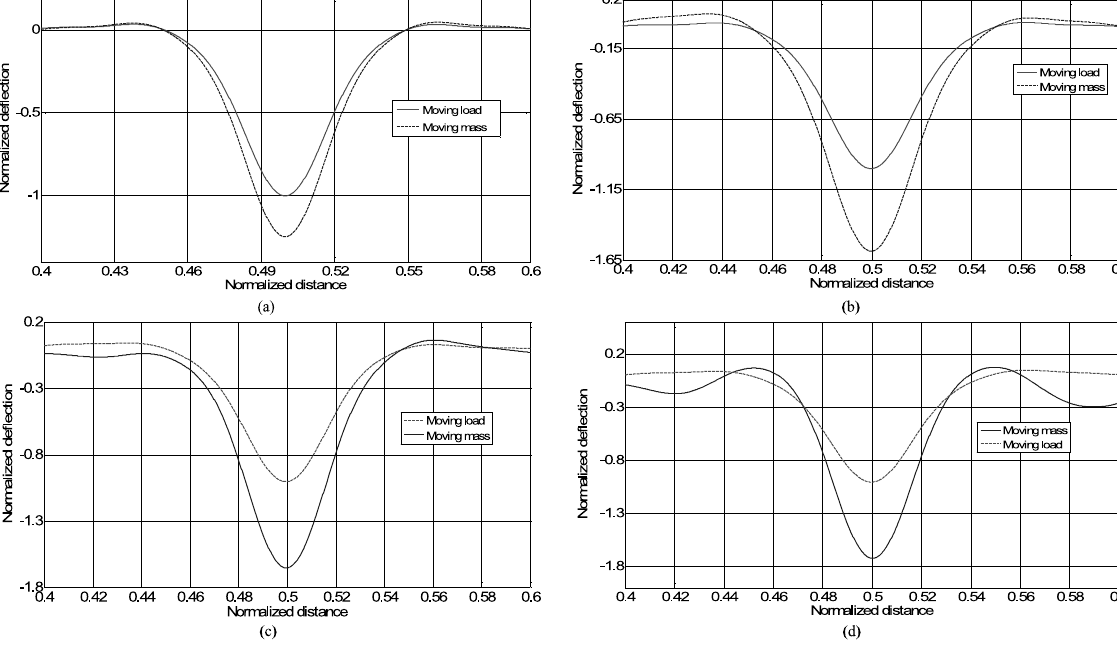
Fig. 5. Normalized de fl ection response with different velocity ratios; (a) velocity ratio = 0.025; (b) velocity ratio = 0.05; (c) velocity ratio = 0.075; (d) velocity ratio =